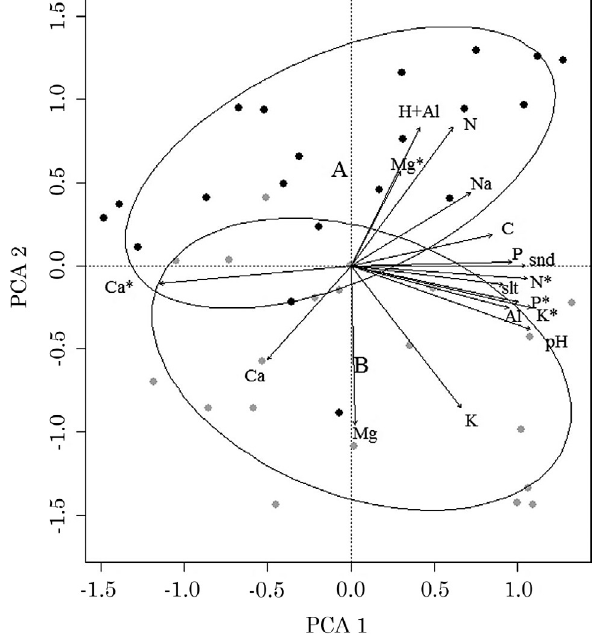
table 4. Correlation values between the soil and litter properties and each of the first two components